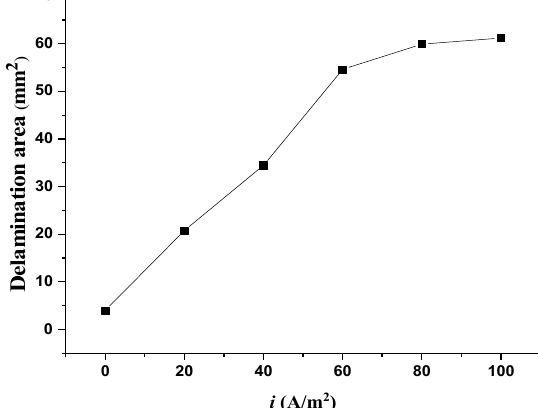
Figure 9. Cathodic disbondment of the 3PE coating of the X80 steel samples as function of the DC current density under DC cathode polarization.